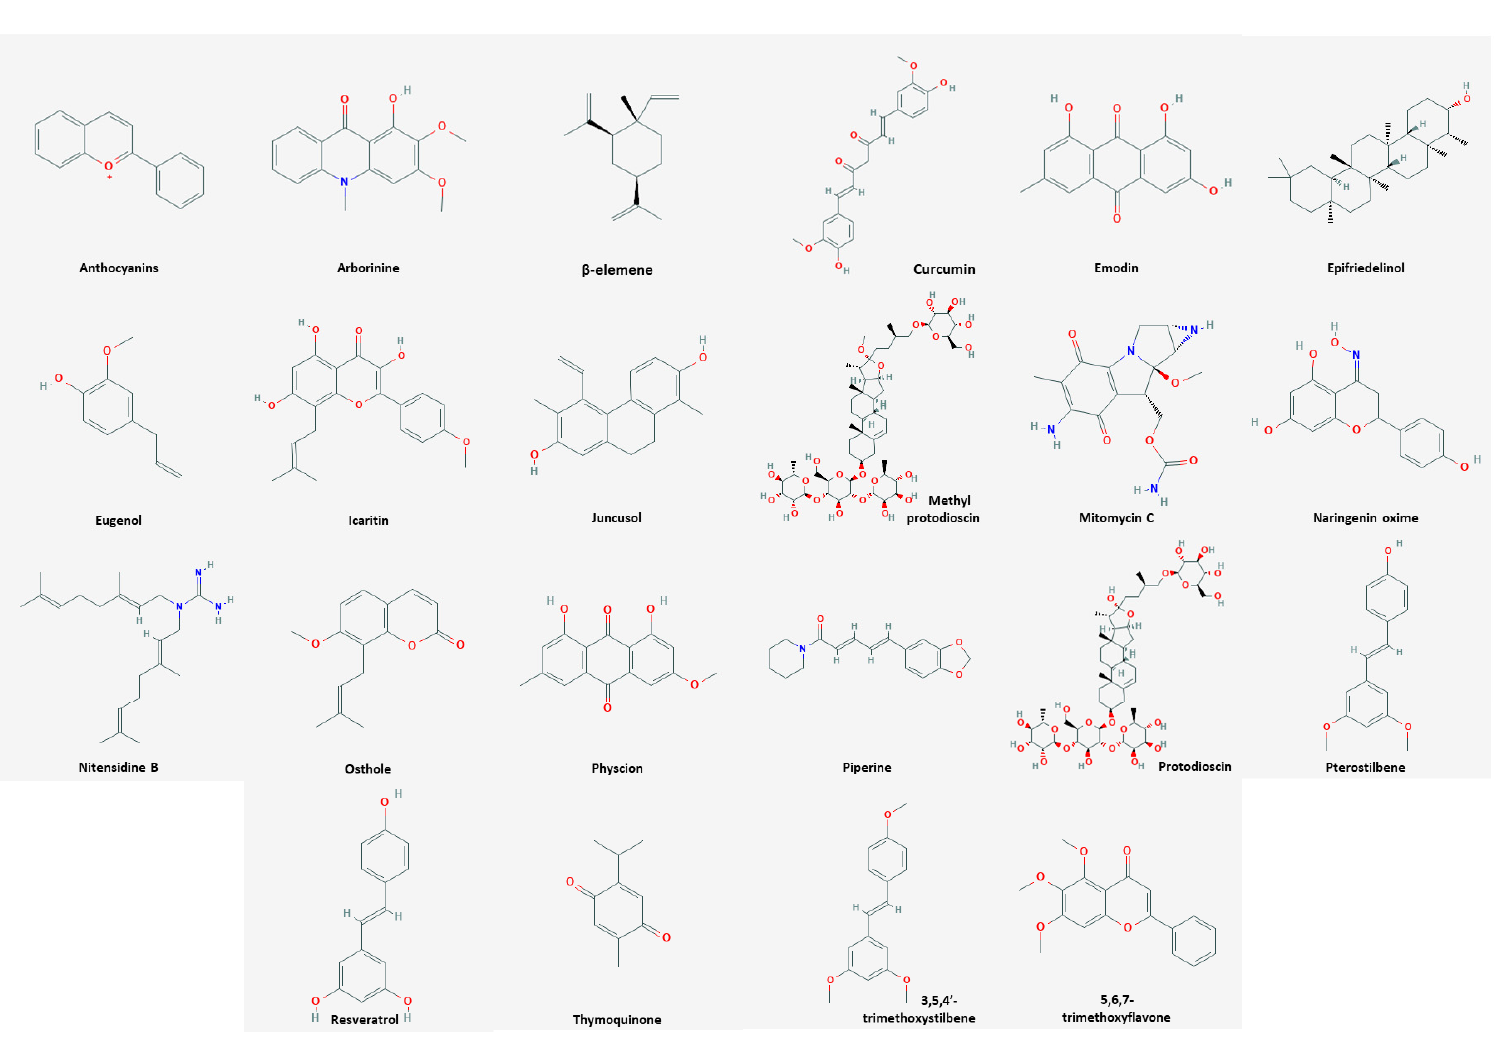
Figure 1. Chemical structures of compounds derived from natural products inducing apoptosis.